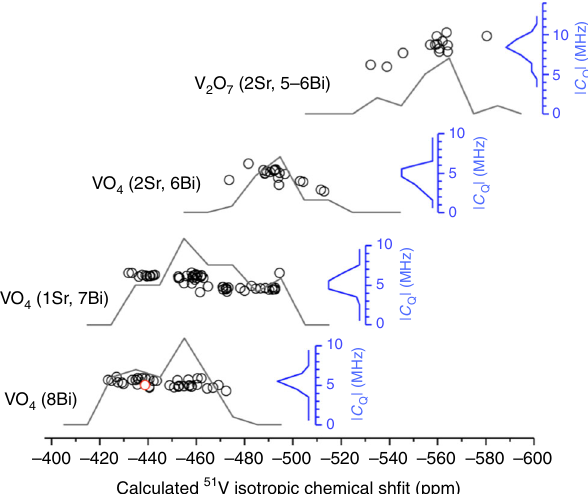
Fig. 4 Calculated 51 V isotropic chemical shift. Calculated 51 V isotropic chemical shift ( δ ISO ) and quadrupolar coupling constants (| C Q |) for isolated VO 4 tetrahedra with different number of Sr/Bi atom neighbors in their second coordination spheres and V 2 O 7 dimers in Sr 0.125 Bi 0.875 VO 3.9375 . Black and blue lines correspond to histograms of calculated δ ISO and (| C Q |),